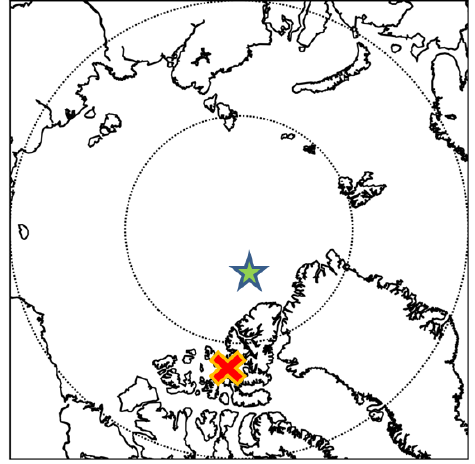
Figure 1. Map of the Arctic centred on the North Pole. Stars show centre of model grids used in this study. Green – northwest Alert (NW Alert) grid; orange – Axel grid. Grid sizes are approximately 440km(N–S) × 72km (E–W).